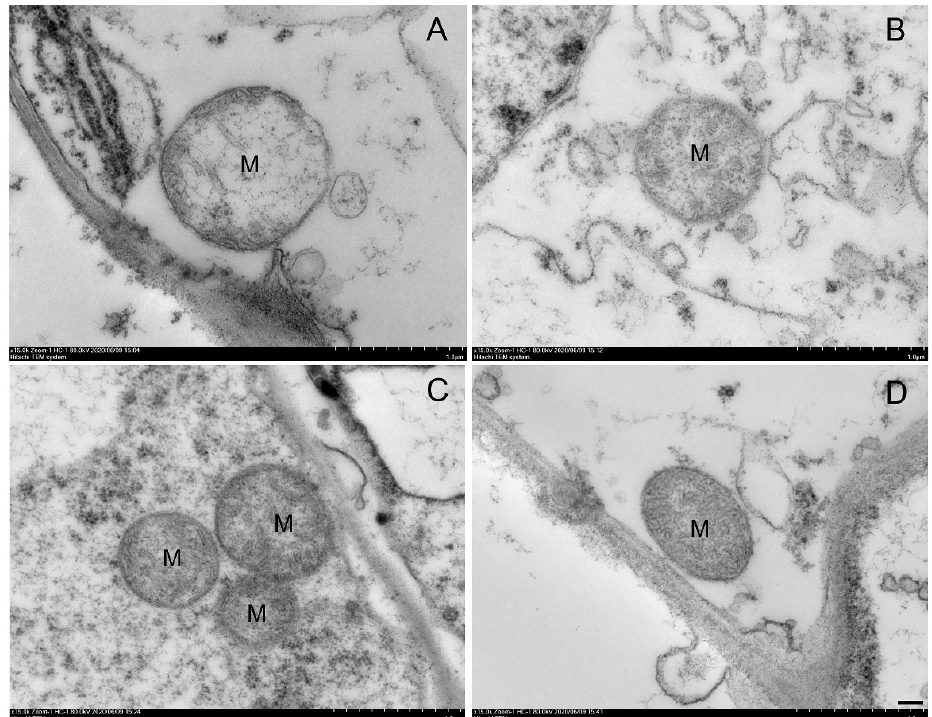
Figure 4. Effects of NO and MAP treatment on mitochondrial ultrastructure in control ( A ), NO ( B ), MAP ( C ), and NO + MAP ( D ) water bamboo shoots stored at 4 ◦ C for 28 d. M represents mitochondria. Pictures show 15,000 × magnification. Bar represent 1 µ m.